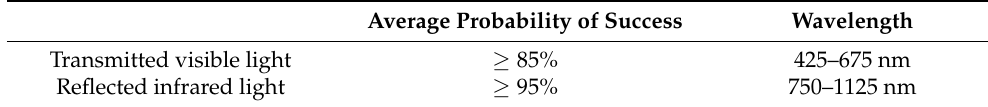
Table 2. Specifications of the plate beam